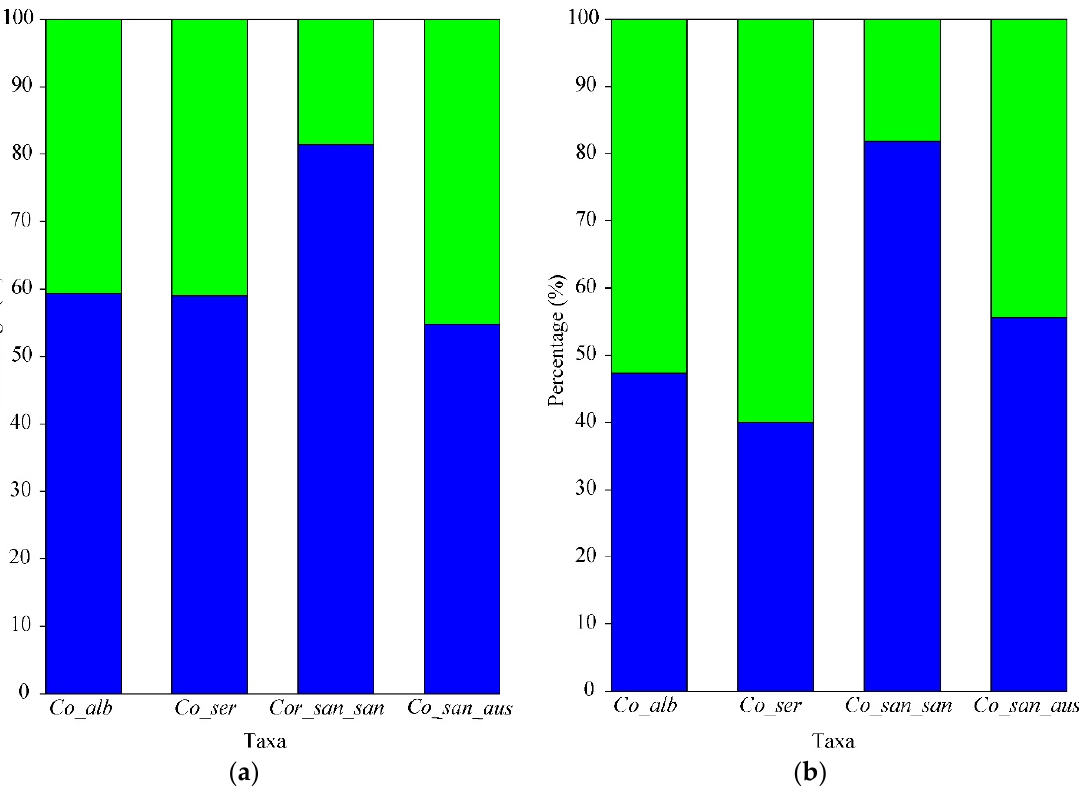
Figure 3. Ratio of viable (green) and non-viable (blue) seeds in different soil layers. ( a )—in the upper layer; ( b )—in the lower layer. Abbreviations of taxa: Co_alb— Cornus alba ; Co_ser— Cornus sericea ; Co_san_san— Cornus sanguinea subsp. sanguinea ; Co_san_aus— Cornus sanguinea subsp. australis .